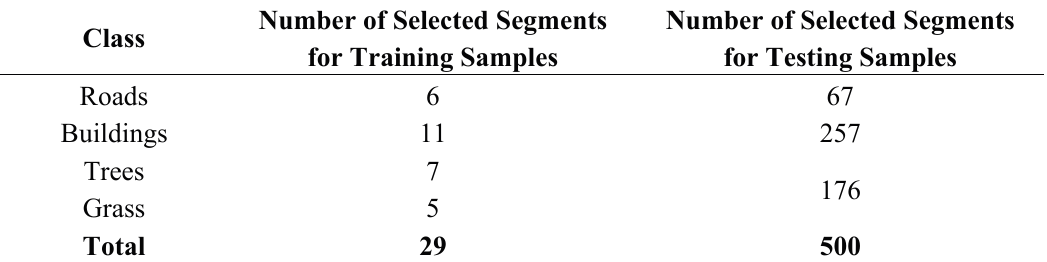
Table 2. The number of selected training and testing samples per individual